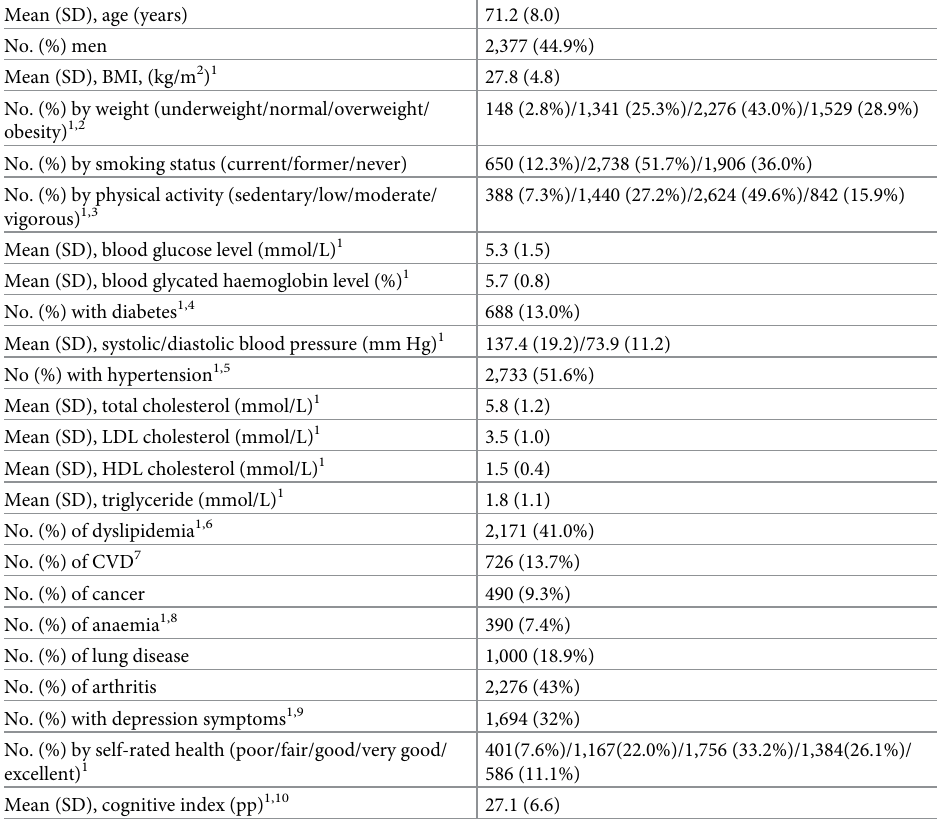
Table 2. Baseline summary characteristics of 5,294 participants in ELSA wave 2